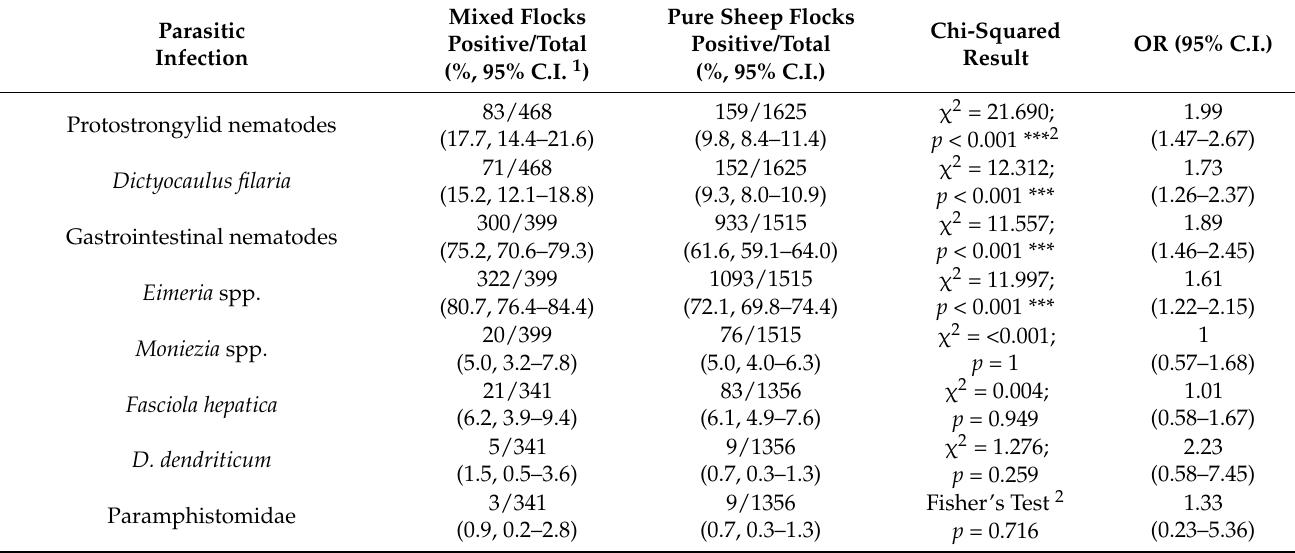
flocks are shown in Table 2. Table 2. Prevalence of parasitic infections in mixed and pure sheep flocks. Distribution analyses and OR depending on goat contact. Parasitic